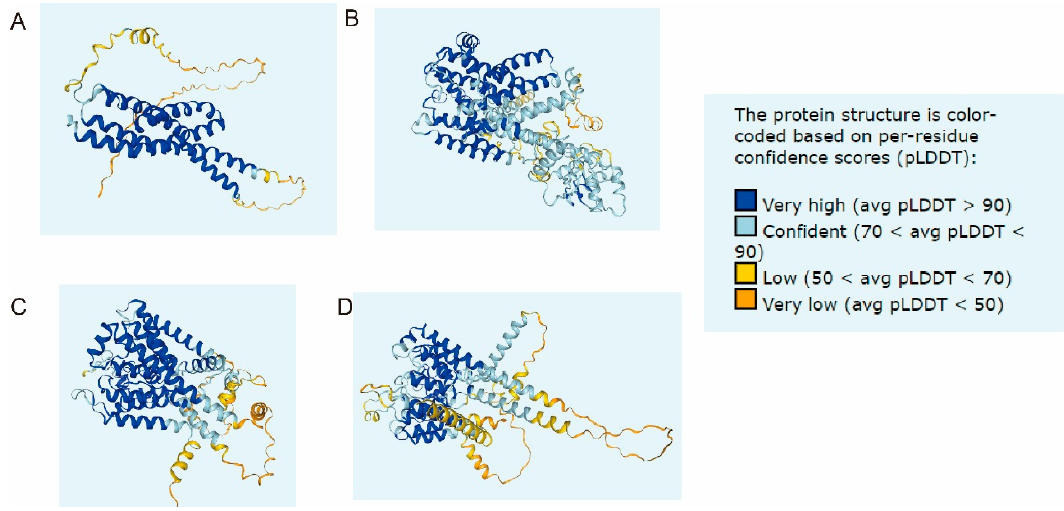
Figure 5. The prediction of the protein structure (www.maizegdb.org, 17 February 2022). ( A ) Zm00001d053925 ; ( B ) Zm00001d04998 7 (ZmHAK4); ( C ) Zm00001d040627 (ZmHKT1); ( D )